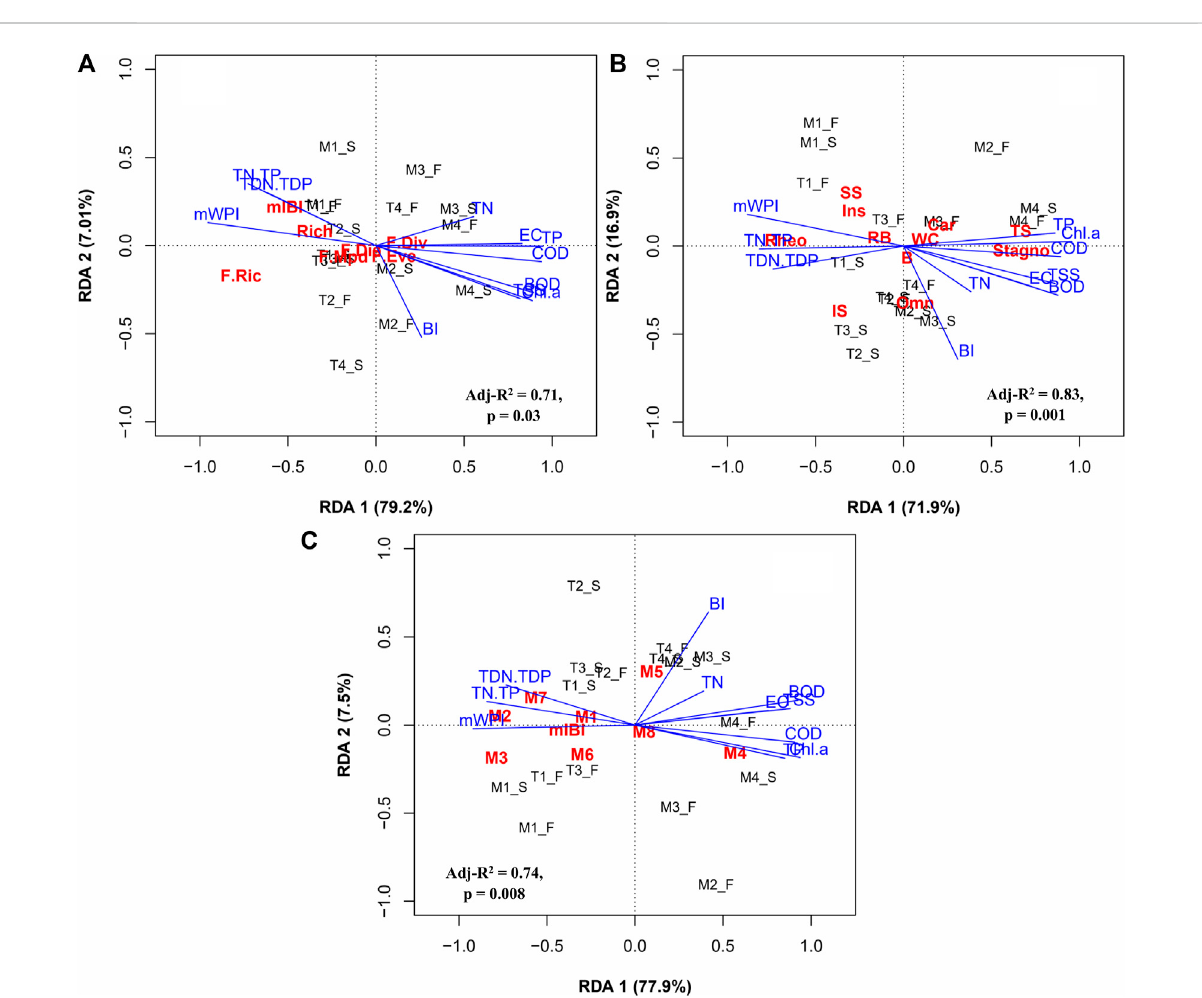
FIGURE 9 Redundancy analysis (RDA) plots on (A) responses of functional diversity indices (B) responses of functional trait metrics, (C) responses of the mIBI metrics to water quality variation and chemical health. The abbreviations of the response and explanatory variables were available in Materials and Methods. The black letters (M1_S, etc. ) indicate the study site and season (S-spring and